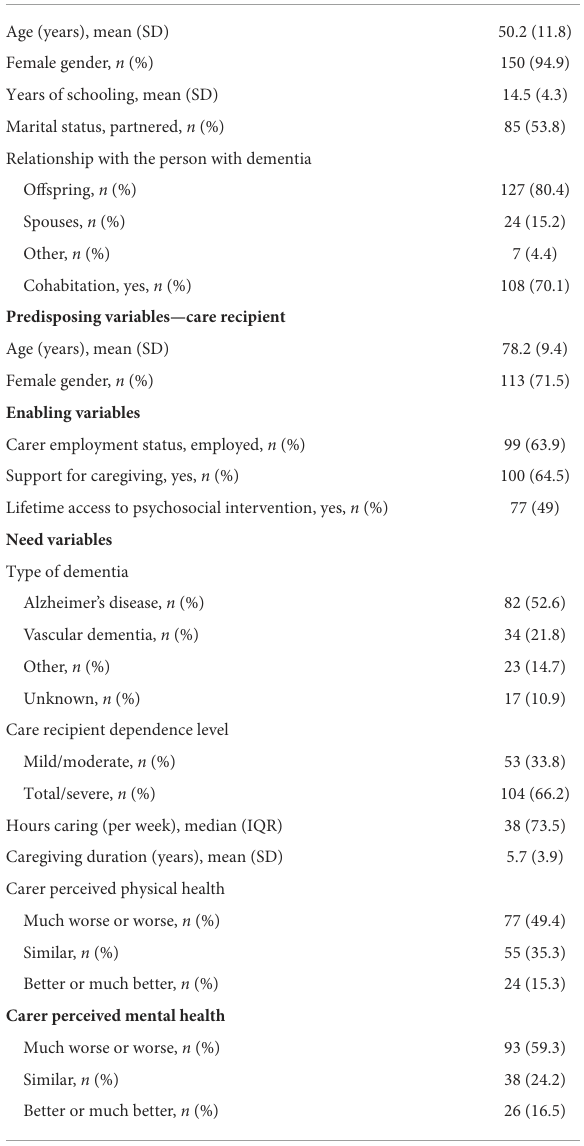
TABLE 2 Sample characterization on predisposing, enabling, and need variables ( N =